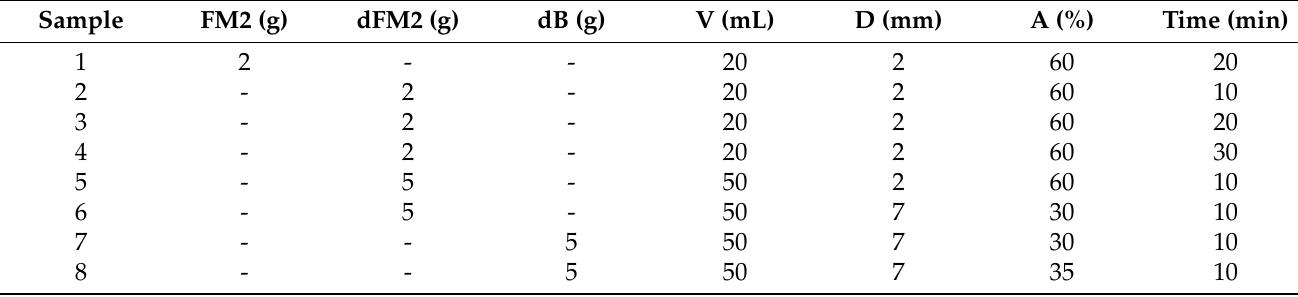
Table 1. Experimental conditions [probe diameter (D), amplitude (A) and time] used in ultrasound assisted extraction of cannabinoids from FM2, decarboxylated FM2 (dFM2) and Bedrocan ® (dB) at 115 ◦ C in 20 or 50 mL olive